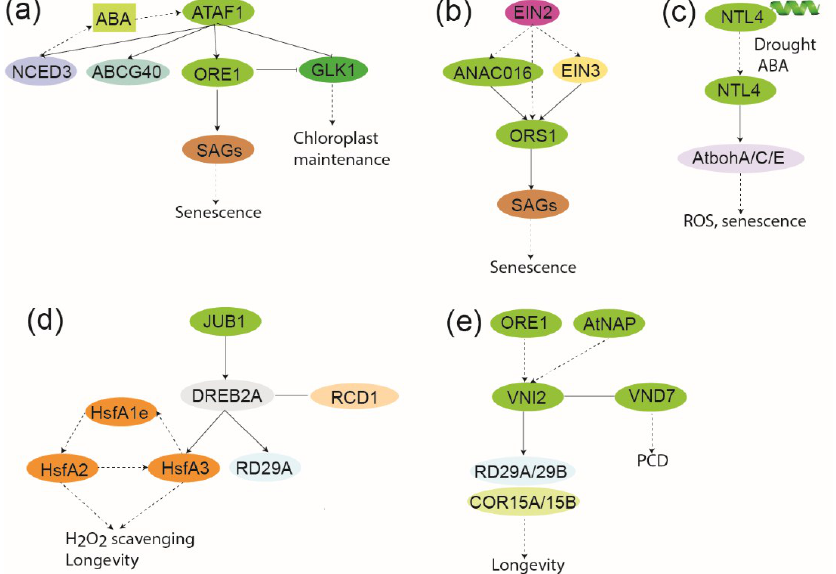
Figure 5. Schematic showing local GRN of senescence associated NAC genes ( a ) GRN of ATAF1. The ATAF1-NCED3/ABCG40/ORE1/GLK1 connection is derived from